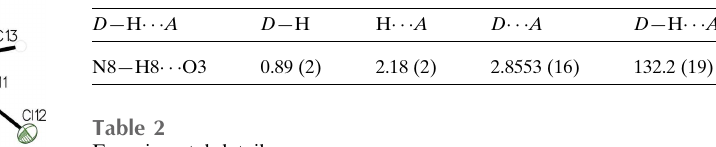
Table 1 Hydrogen-bond geometry (A˚ , (cid:4) ).